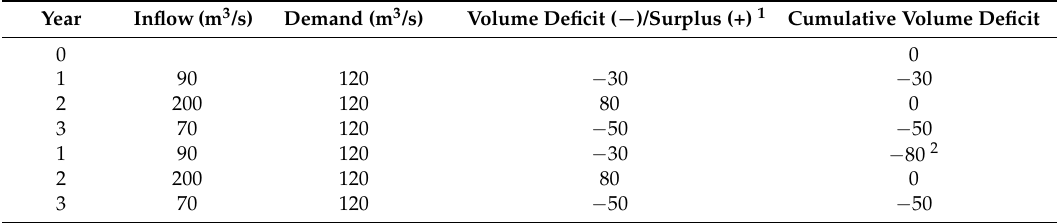
Table 2. Computation of storage capacity for V T = 0.